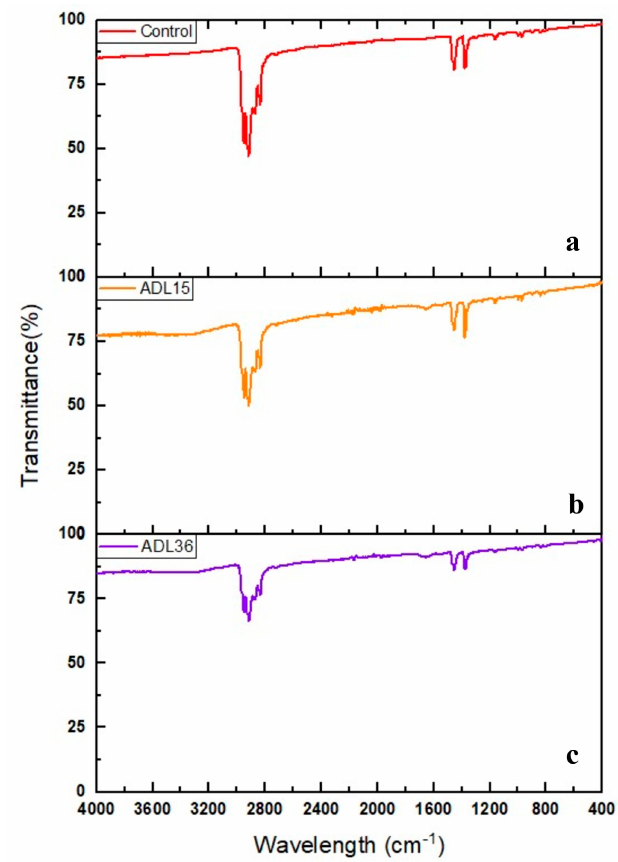
Figure 2. The Fourier transform infrared (FTIR) spectrum of polypropylene (PP) microplastics: ( a ) before incubation with bacteria, ( b ) after 40 days of incubation with Pseudomonas sp. ADL15, and ( c ) after 40 days of incubation with Rhodococcus sp. ADL36.